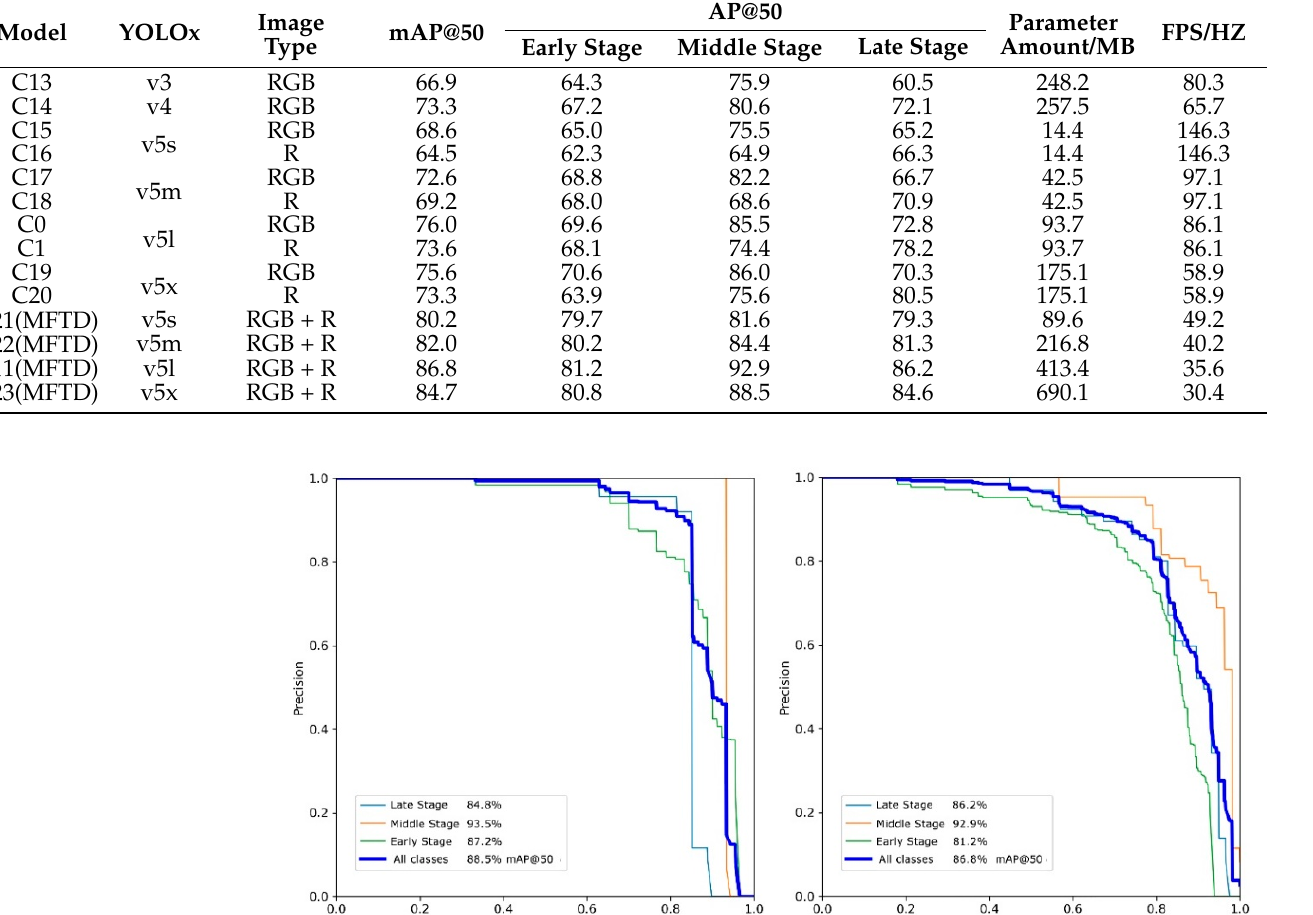
Table 9. Detection performances of YOLO series and MFDN on CP Dataset.